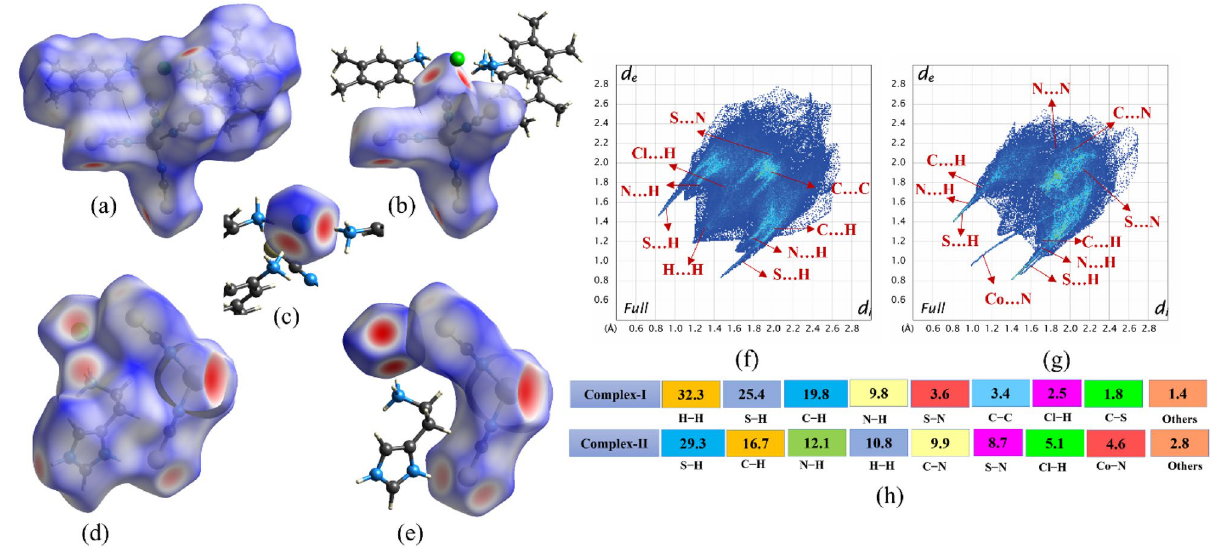
Figure 11. The dnorm map of Hirshfeld surface analysis and their Fingerprint plots with contribution (%) for both ( a-c,f ) complex-I and ( d-e,g )